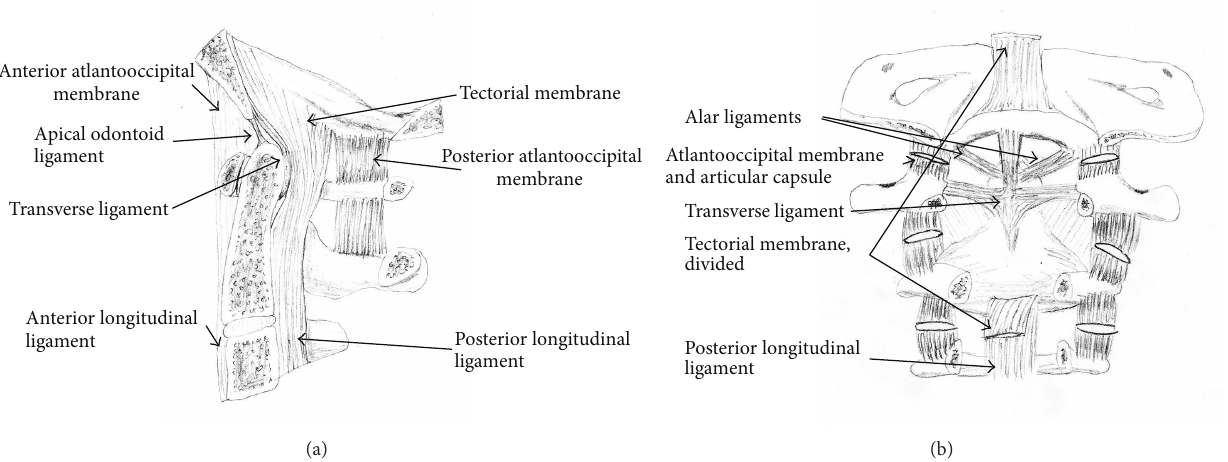
Figure 1: (a) Sagittal view of occipitocervical complex. (b) Posterior view of occipitocervical complex. (Reprinted with permission [9]. Promotional and commercial use of the material in print, digital, or mobile device format is prohibited without the permission from the publisher Lippincott Williams & Wilkins. Please contact journalpermissions@lww.com for further